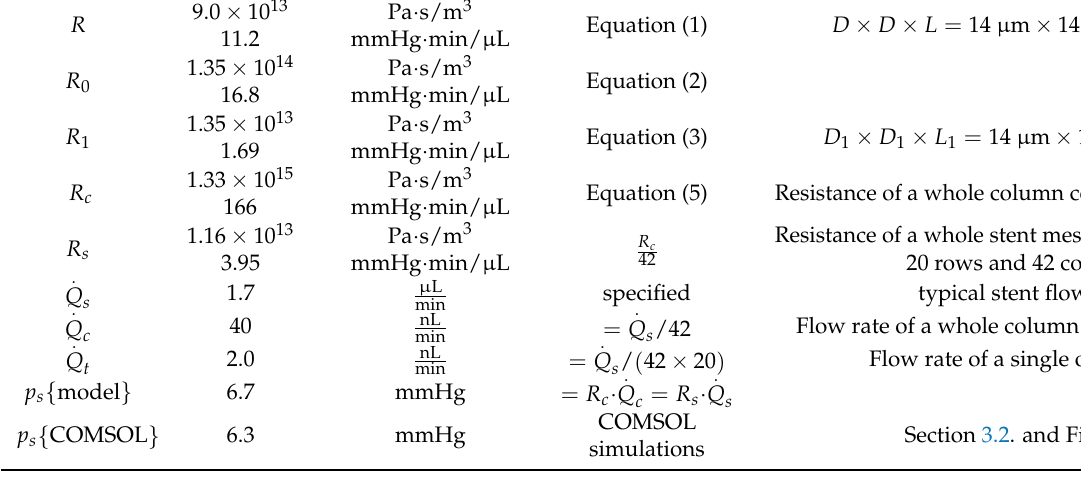
Table 2. Resistances, flow rates and pressures of the meshwork of Figures 1 and 2. The resistances R and R 1 are obtained from the channel geometry. The stent flow rate surgery. The pressure difference p s across the stent is then calculated with the stent fluid model using the mentioned quantities or with COMSOL simulations using the specified geometry.